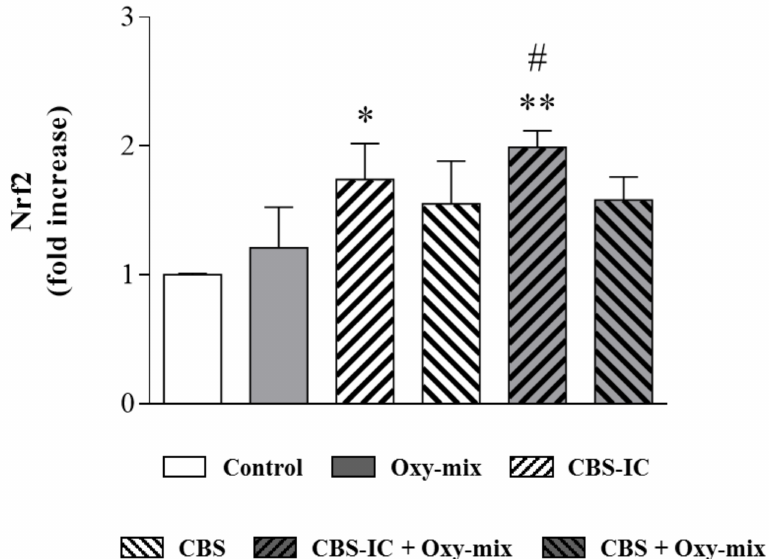
Figure 4. Oxysterol-dependent Nrf2 gene expression was upregulated by CBS-enriched ice cream. Nrf2 gene expression was evaluated by qRT-PCR in differentiated CaCo-2 cells treated with 60 µ M Oxy-mix for 6 h, and pretreated or not with CBS-IC or CBS alone for 1 h. Data are expressed as fold induction than control sample. Preincubation with CBS-IC showed a significant fold increase com- pared with Oxy-mix treatment. Data are reported as means of three independent experiments ( n = 3) evaluated in triplicate ± SD. One-way analysis of variance (ANOVA) associated with Bonferroni’s multiple comparison post-test was adopted: Significantly different vs. controls: * p < 0.05, ** p < 0.01; significantly different vs. Oxy-mix: # p <